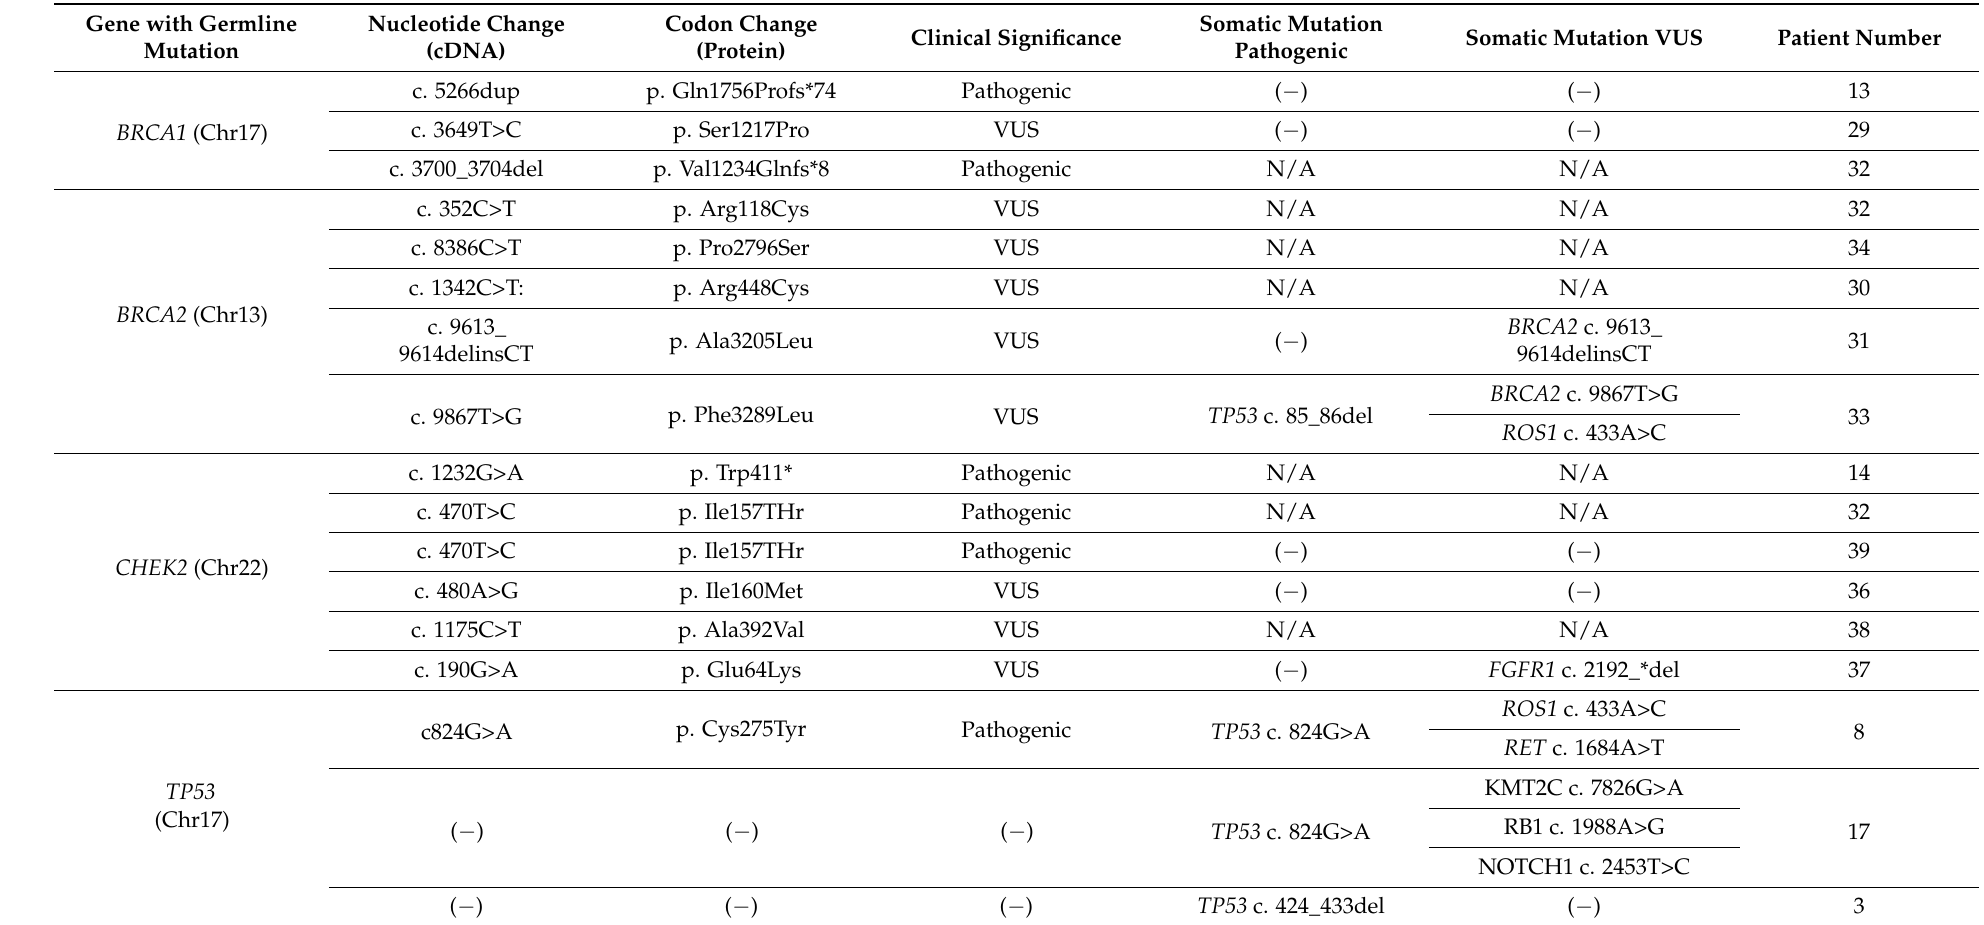
Table 2. Germline and Somatic mutations identified in premenopausal breast cancer